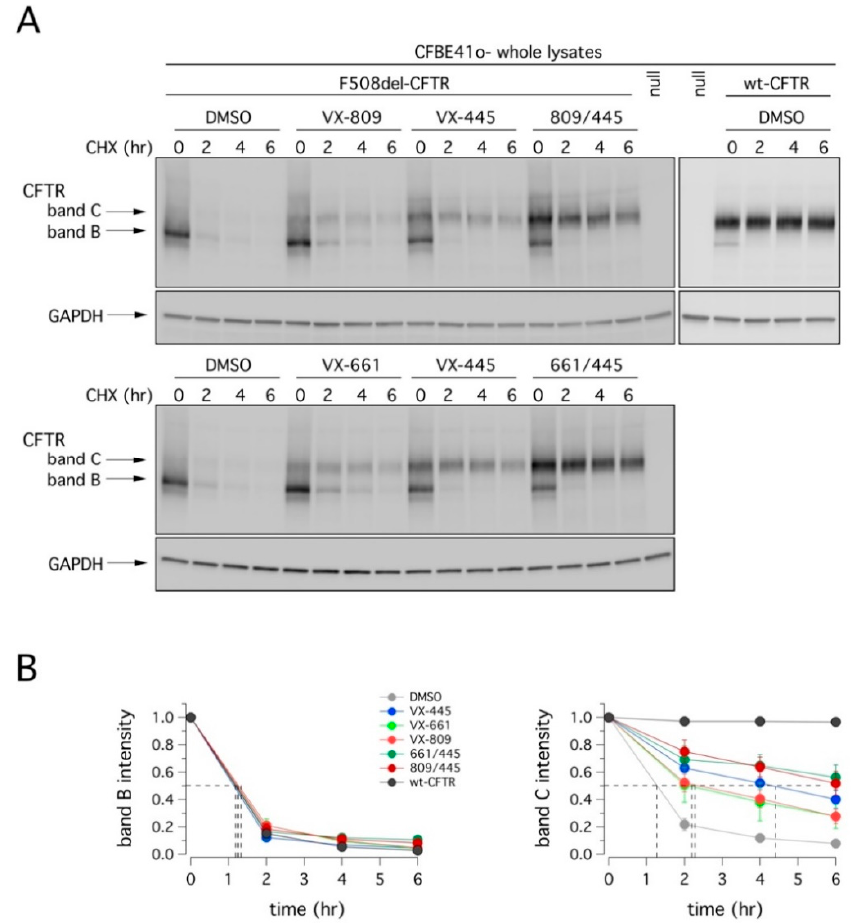
Figure 5. Effect of VX-445-based treatments on mutant CFTR half-life. ( A ) Immunoblot detection of CFTR in whole lysates derived from wild-type or F508del-CFTR expressing CFBE41o- cells treated with vehicle alone (DMSO), or (for mutant CFTR only) with VX-445 (3 µ M), VX-809 (3 µ M), or VX-661 (10 µ M) as single agents or combinations, at different time points following CHX-induced block of protein synthesis. For comparison, whole lysates derived from CFBE41o- cells not expressing CFTR (null cells) are also shown as controls for antibody specificity. ( B ) Quantification of wild-type or mutant CFTR (band B and band C) half-life in experiments detailed in ( A ), normalized by the value at time = 0. Data are means ± SD ( n = 3). Dashed lines indicate 50% of the protein remaining ( y -axis) and the corresponding intercepts on the x -axis, indicating the estimated